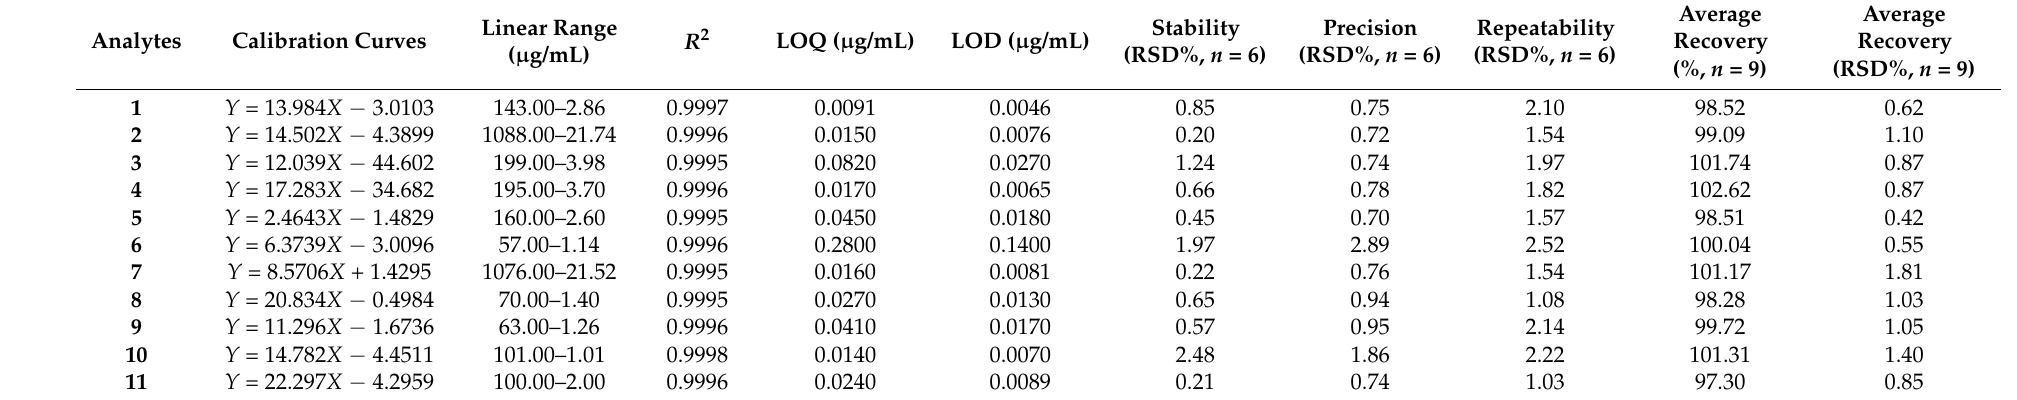
Table 1. Analytical properties for validated UHPLC-DAD